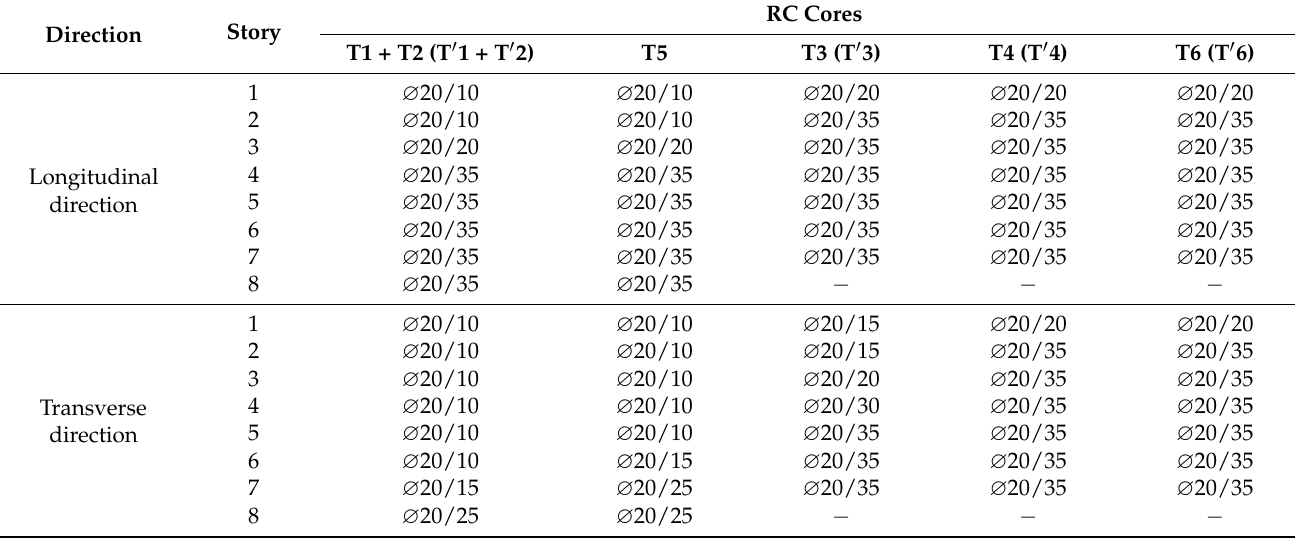
Table 12. Steel reinforcing bars for I1 intervention ( ζ E ≥